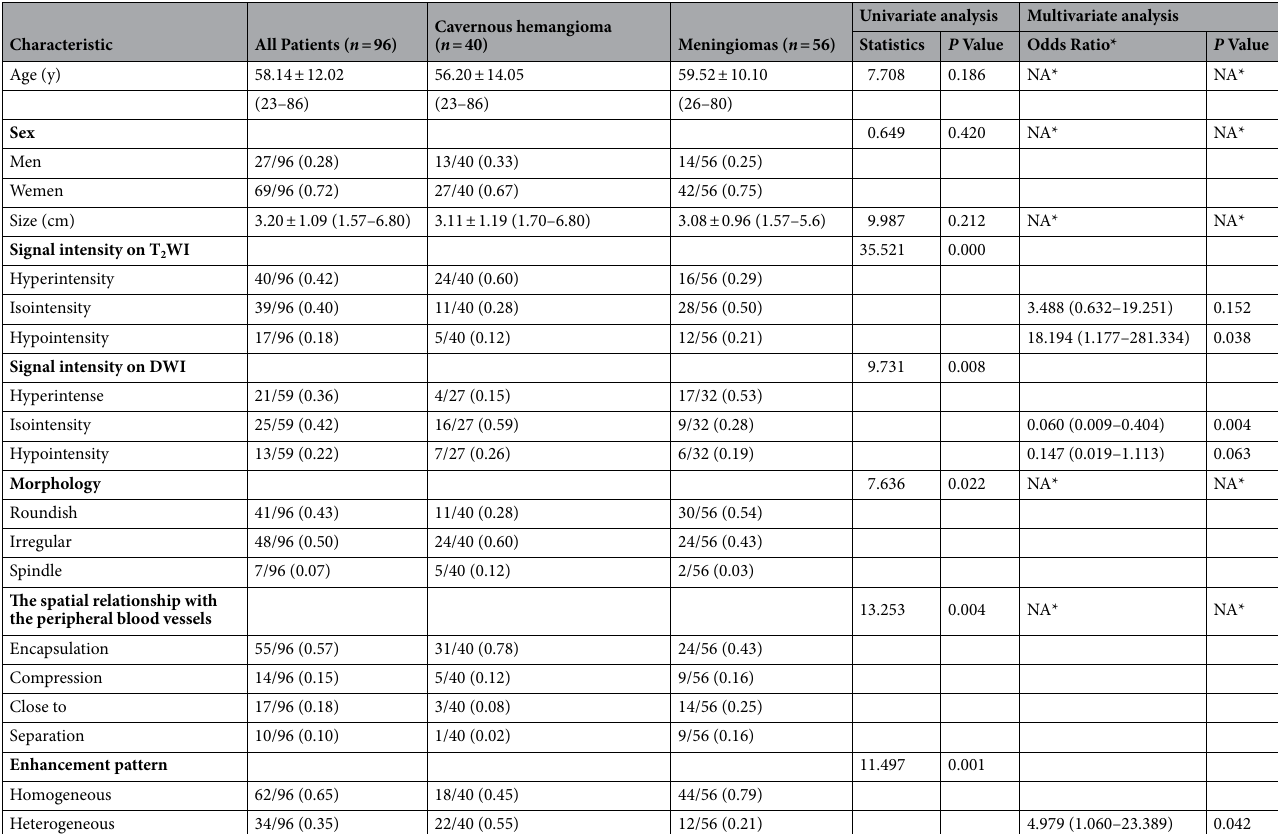
Table 2. Baseline characteristics and semantic image analysis of the population study. NA not analyzed, DWI diffusion-weighted imaging.